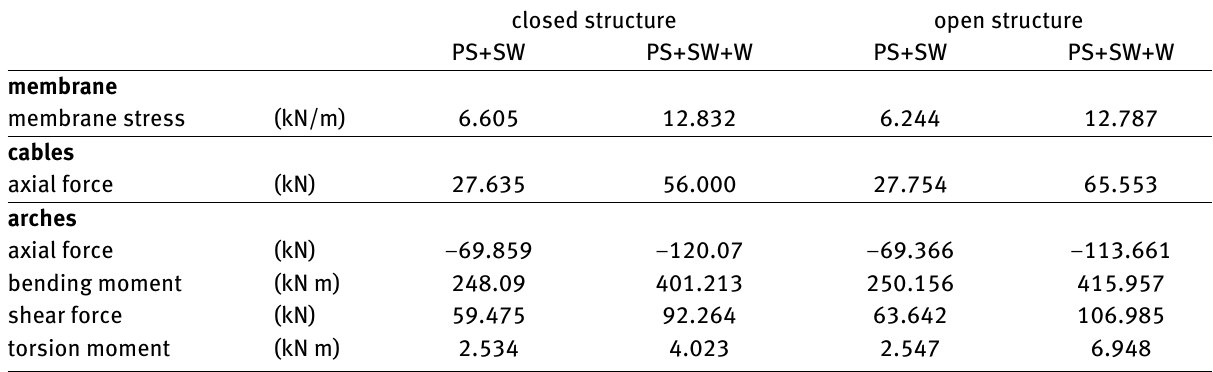
Table 3: Maximum values of internal actions for the ULS, for both the closed structure and the open structure, considering prestress (PS) and self-weight (SW), with and without wind load (W).